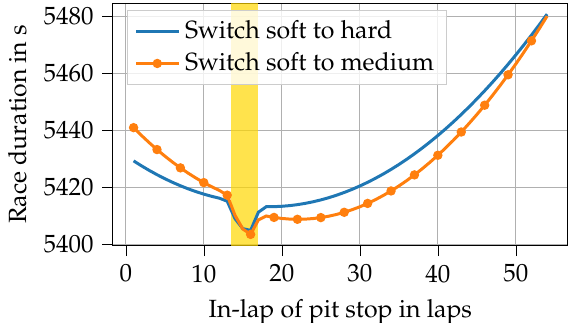
Figure 2. Race durations in an example 1-stop race with a full-course yellow phase lasting from the middle of lap 14 until the end of lap 17 in relation to the pit stop lap. Two example compound choices are